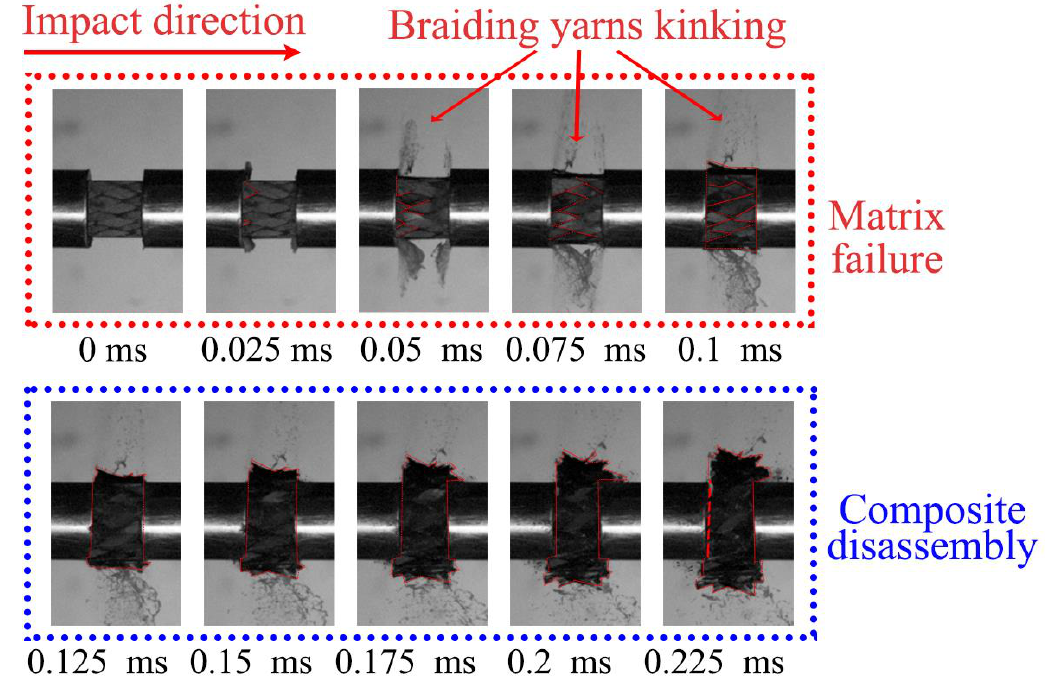
Figure 12. Typical dynamical compressive process for the 3D four-step braided composite under strain rate 1845 s −1 , after 210 cyclic hygrothermal aging days.